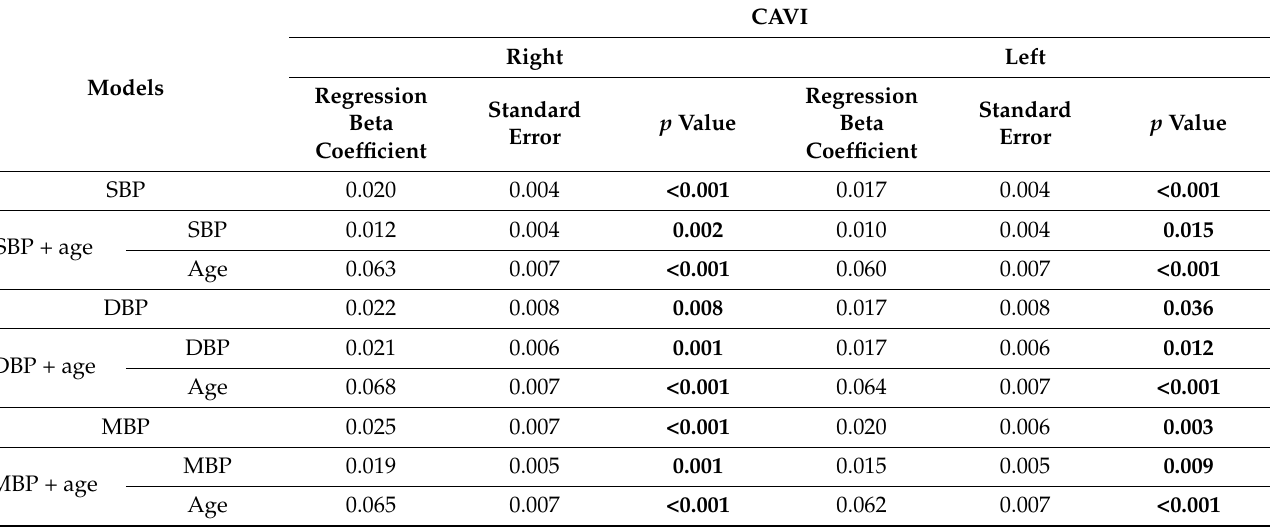
Table 4. Linear regression models to assess the independency of the association between blood pressure indices and CAVI.